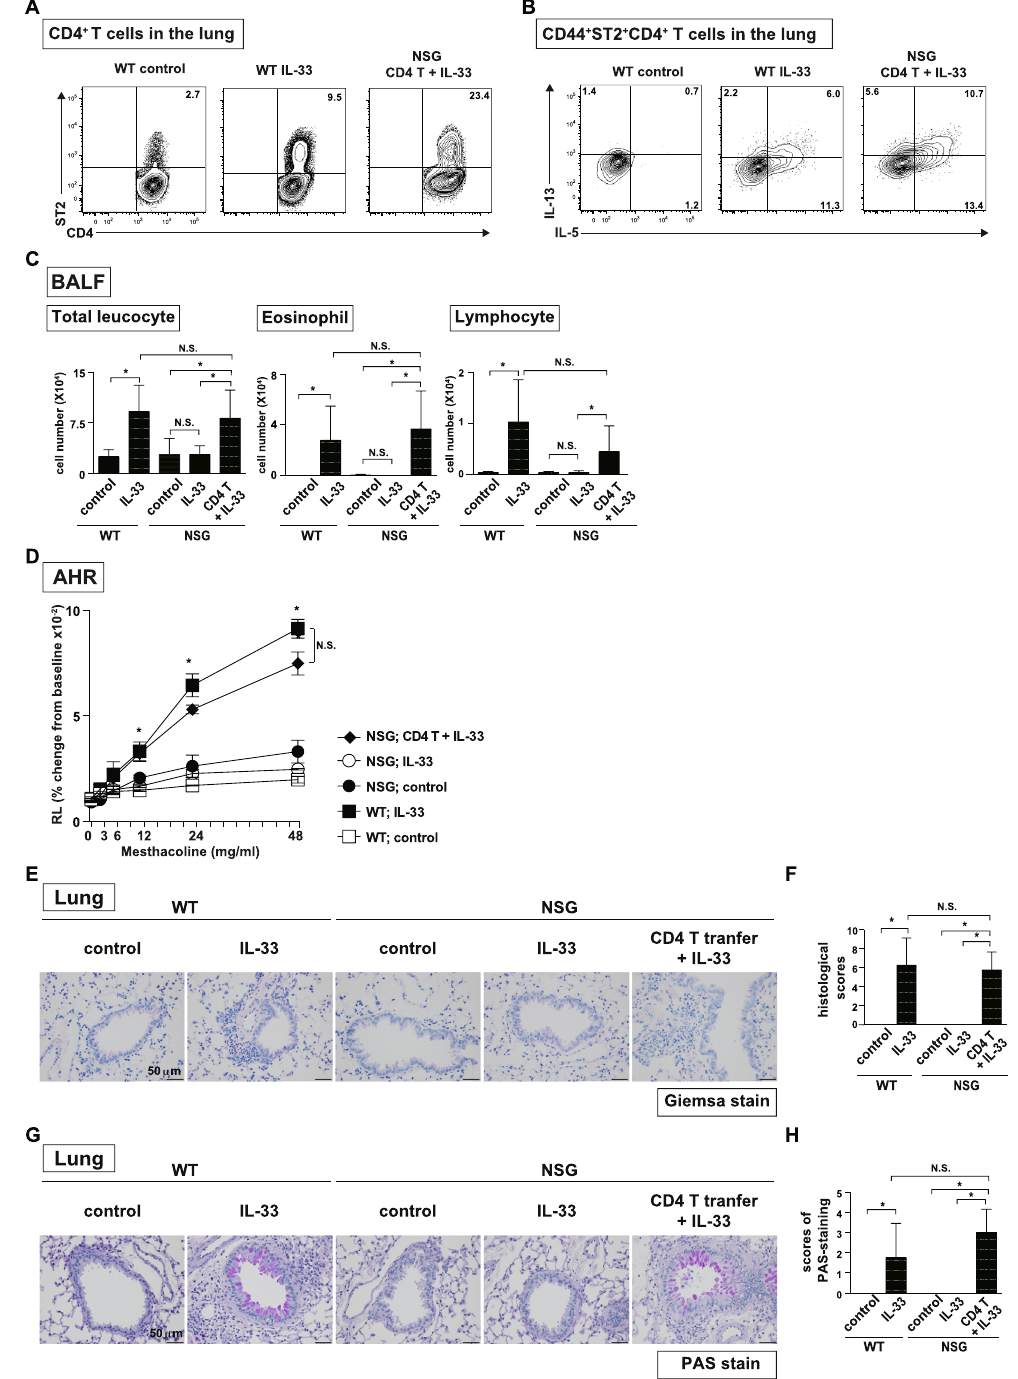
Figure 4. Adoptive transfer of CD4 + T cells restored IL-33-induced eosinophilic inflammation in NSG mice. ( A ) Representative flow cytometry plots of ST2 + CD4 + T cells in the lung are shown. ( B ) Representative intracellular staining profiles of IL-5 and IL-13 are shown on CD44 + ST2 + CD4 + T cells from wild type mice (BALB/c) and NSG mice with adoptive transfer. ( C) Saline (control) or IL-33 was administered intratracheally to wild type (BALB/c) mice and NSG mice with adoptive transfer of CD4 + T cells and BAL was performed at day 14. The numbers of total leukocytes, eosinophils and lymphocytes in the BAL fluid are shown. * p < 0.05: one-way ANOVA. N.S. means not significant. ( D) Lung resistance (RL) was assessed in response to the increasing doses of methacholine. The mean values (four mice per group) are shown with SDs. * p < 0.05: one- way ANOVA. N.S. means not significant. ( E – H) Microscopic pictures of the lungs from mice, fixed and stained with H.E. ( E ) and PAS ( G ) reagent. Scale bars: 50 μ m. Histological scores from HE-stained samples ( F ) and PAS- stained samples ( H ) are